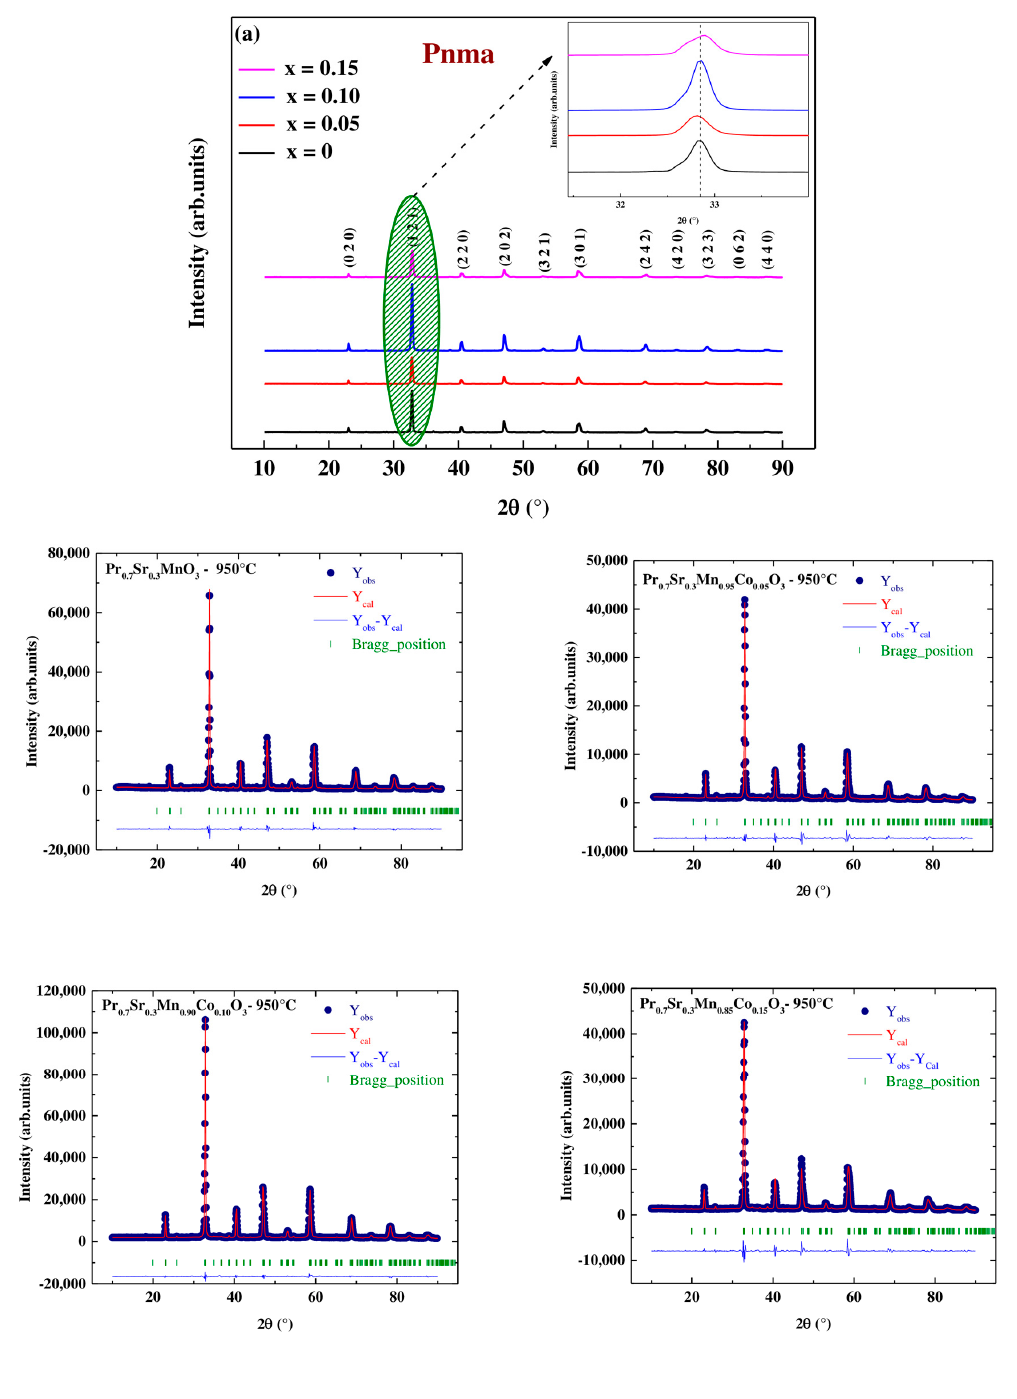
Figure 2. ( a ) X-ray diffraction patterns of Pr 0.7 Sr 0.3 Mn ( 1 − x ) Co x O 3 (x = 0, 0.05, 0.10 and 0.15) com- pounds at room temperature. ( b ) Profile of the measured (Open circles) and calculated (Strong lines) intensity of the X-ray diffraction lines obtained by the Rietveld method. The vertical bars in green are Bragg’s reflections for the Pnma space group. The difference between the observed and calculated intensity is shown in blue at the bottom. The values of the ionic radii of the different cations were taken from the Shannon studies [35]. Since orthorhombic distortion is allowed for 0.75 (cid:3409) T (cid:2891) (cid:3409) 0.95 , the T G values obtained in Table 2 confirm that our compounds crystallize in this system. 2. Structural parameters refined by the